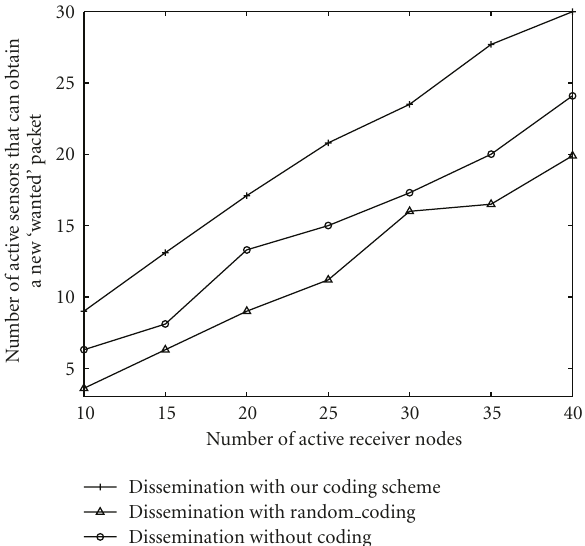
Figure 5: Total number of transmissions versus number of packets needed to be